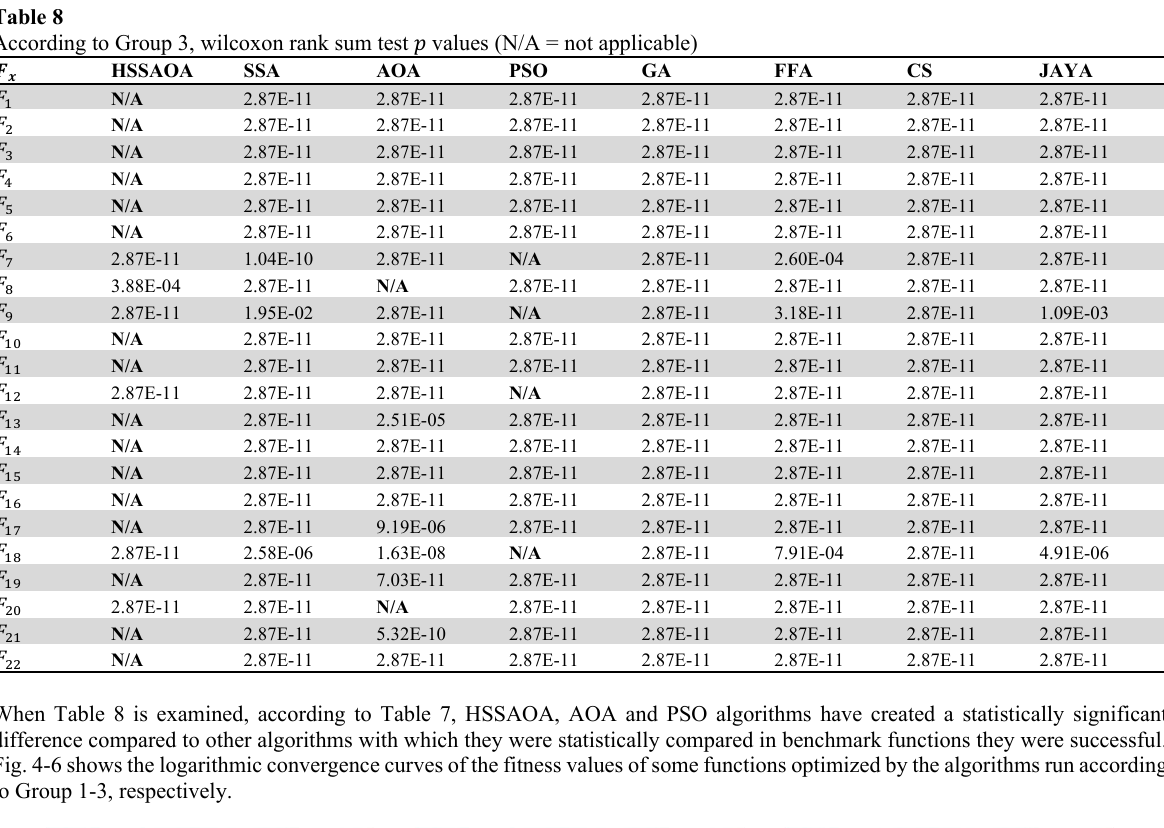
According to the data in Table 7, HSSAOA achieved the best results in a total of 16 benchmark functions, 8 of which are unimodal and 8 of which were multimodal, as in previous analyzes (Table 3 and Table 5). In the benchmark functions that HSSAOA was successful, the second successful algorithm was AOA with 14 benchmark functions. AOA (in 2 benchmark functions) and PSO (in 4 benchmark functions) were the other two algorithms that achieve the best results. Table 8 shows the results of the wilcoxon rank sum test of the optimized benchmark functions according to Group 3.